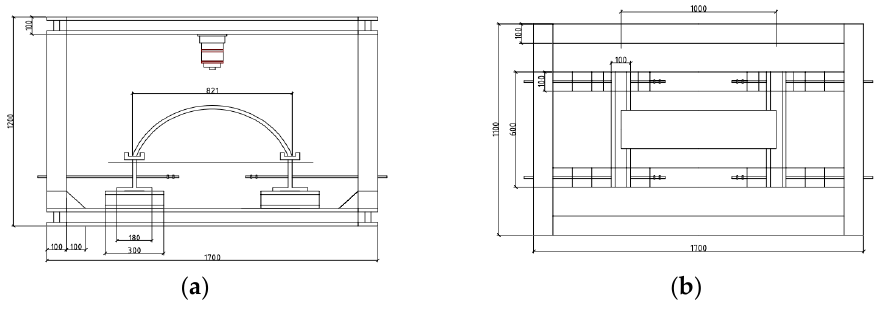
Figure 4. Model loading test device: ( a ) front view; ( b ) top view.